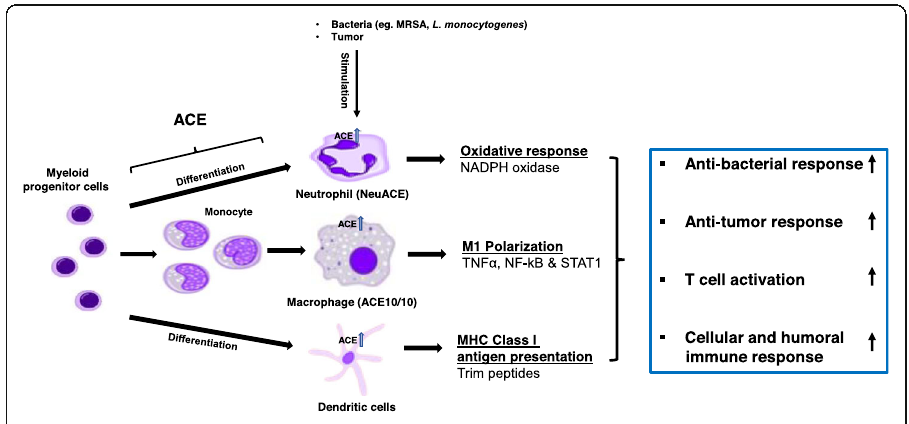
Fig. 1 ACE upregulation enhances myeloid cell immune responses. In physiological conditions, ACE expression increased during the differentiation and functional maturation of myeloid-derived cells. Upon immune challenge, the expression of ACE further increased in activated myeloid cells facilitated the optimal immune responses of these cells. Upregulation of ACE in myeloid cells (eg. NeuACE neutrophils and ACE10/10 macrophages) strongly enhanced immune responses of these cells, beyond the normal capacity of WT cells. In neutrophils, ACE upregulation